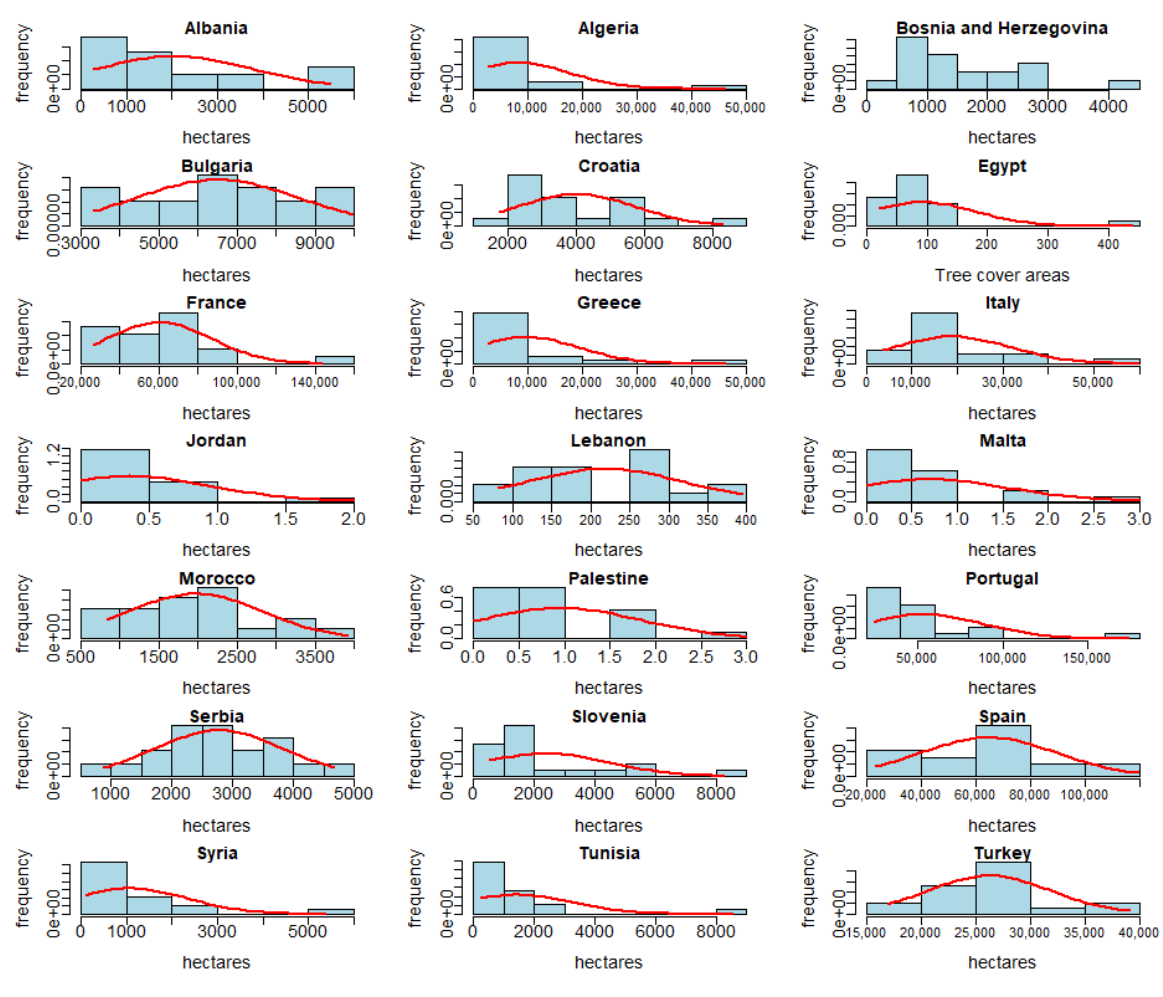
Figure 5. Evolution of the Tree Cover Loss Rate (2019 versus 2001). Figure 4. Histograms of tree cover loss by country (2001–2019). Figure 4. Histograms of tree cover loss by country (2001–2019).